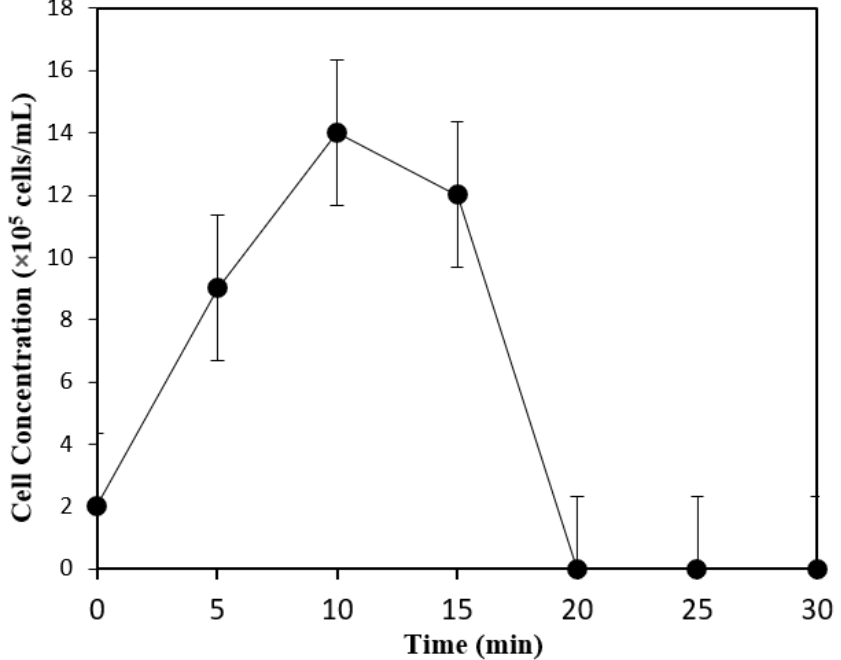
Figure 5. CbCt Cell count of EMS-mutated cells in contact with 15 g/L of Butanol. Figure 6 elucidates the surviving fraction and RF for cells mutated by exposure to UV radiation. The surviving factor decreases significantly with exposure to UV radiation